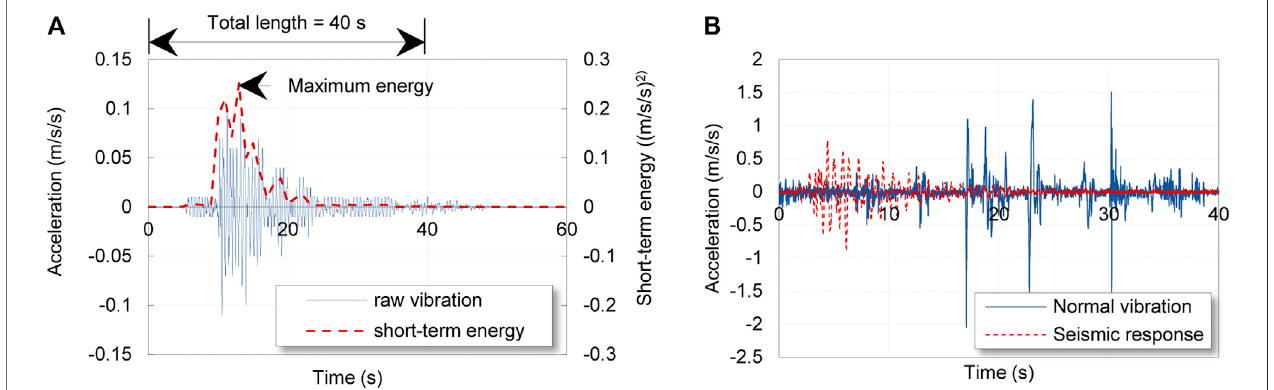
FIGURE 3 | Time-domain characteristics: (A) intercepting vibration based on short-term energy method and (B) typical structural seismic response and normal vibration.